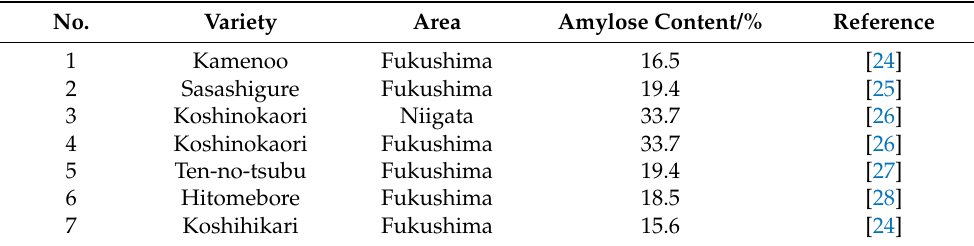
Table 1. Candidate rice